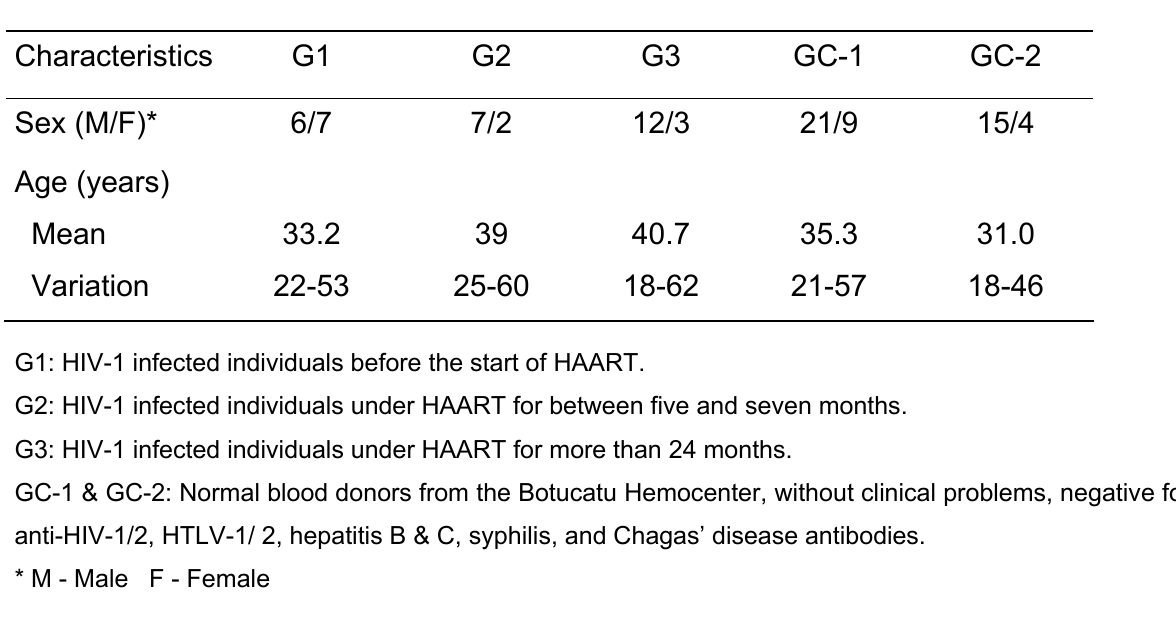
Table 3: Group distributions according to sex and